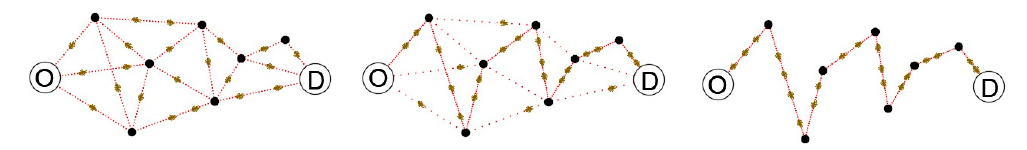
Figure 2. ACO operation scheme in the case study. Indications: O—origin, D—destination.